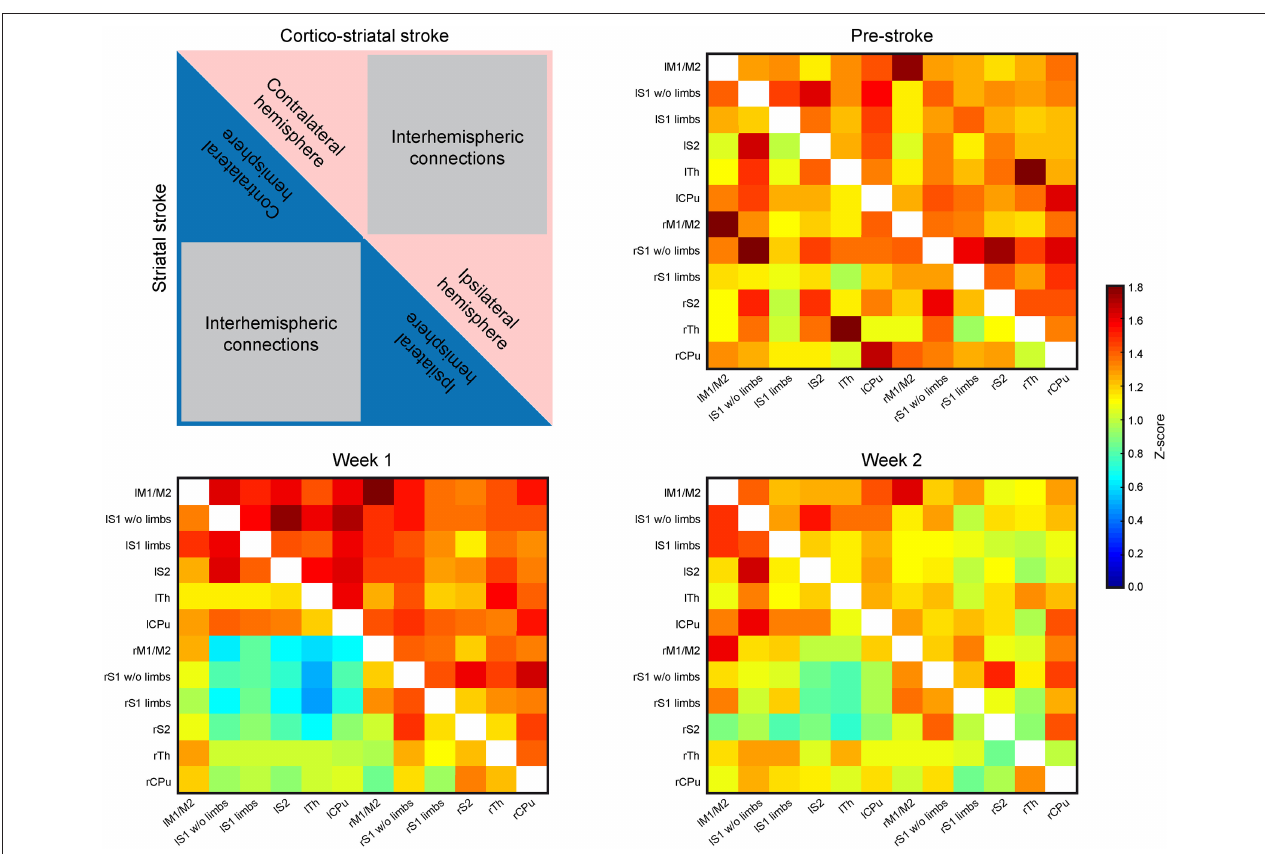
FIGURE 3 | Functional connectivity matrices of the whole brain. The matrices contain the connectivity values ( z -score) of selected brain regions. The distributions of values within the matrices are laid out in the schematic at the upper left. The upper, red triangle stands for the cortico-striatal group, the lower, blue triangle stands for the striatal group. The regions representing intra -hemispheric connectivities of ipsi- and contralateral hemisphere, and the inter -hemispheric connectivities are marked. The three matrices show the ipsi- and contralateral brain connectivity values at pre-stroke time (upper right), at week 1 post-stroke (lower left) and at week 2 post-stroke induction (lower right). During the control time point (pre-stroke) both groups show closely equal connectivity strength across the whole brain (upper right). At week 1 post-stroke induction, the cortico-striatal group shows a slight hyperconnectivity, while the connectivity values of the striatal group remain unaffected by stroke induction, with the exception of a small field of reduced connectivities within the inter -hemispheric connections. At week 2 post-stroke (lower right), both groups show values close to the pre-stroke condition in the intra -hemispheric parts. The inter -hemispheric parts show a reduction relative to the pre-stroke